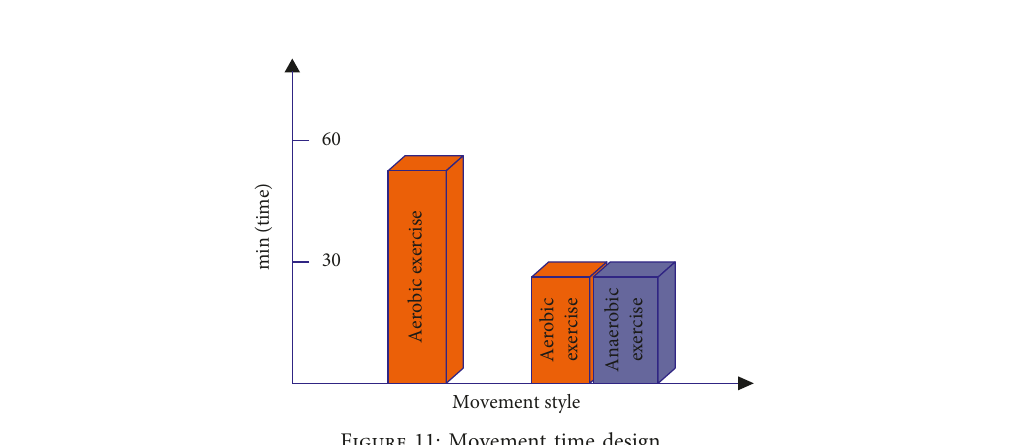
Figure 10: Gated recurrent unit neural network.